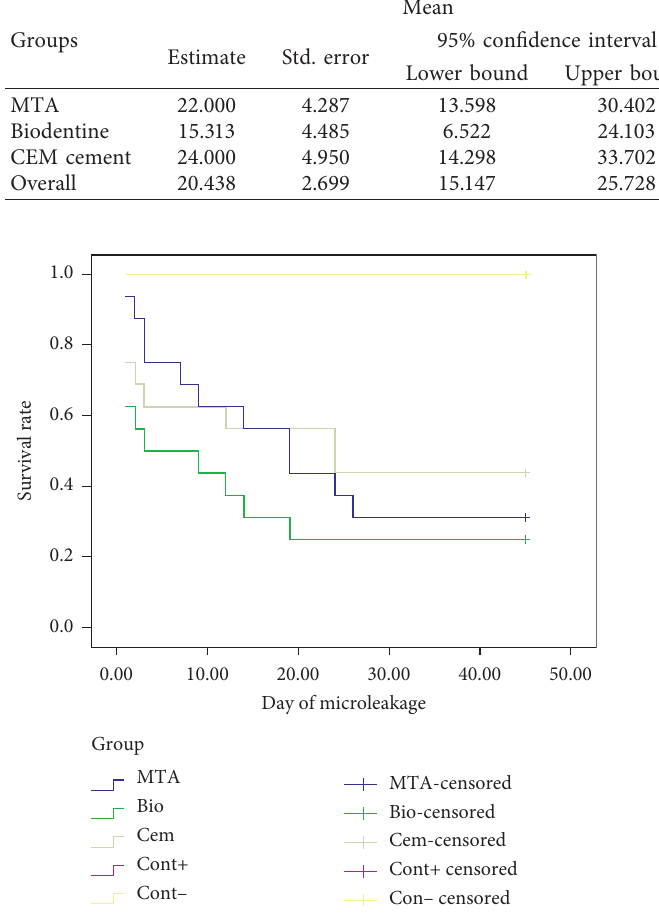
Figure 4: Rate of microleakage over time in experimental groups (338 × 190mm) (96 × 96DPI).